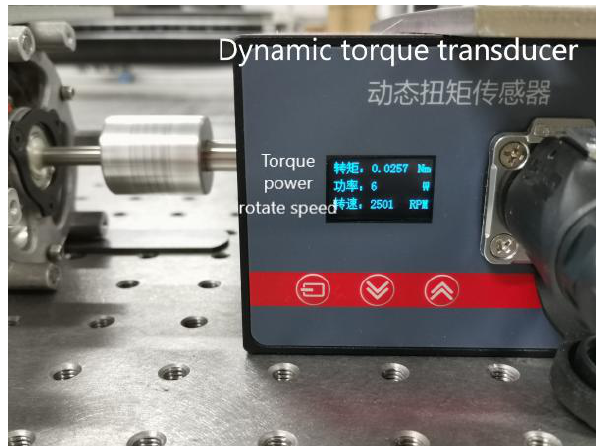
Figure 14. Input power measurements.